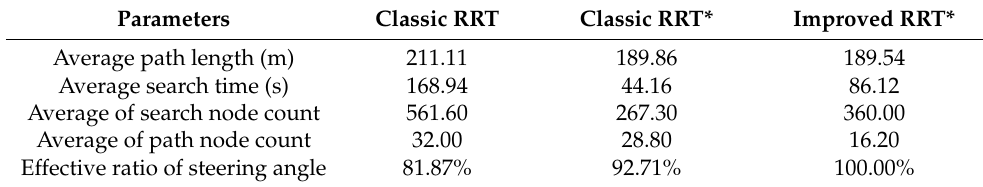
Table 3. Statistics of 10 independent random simulations.